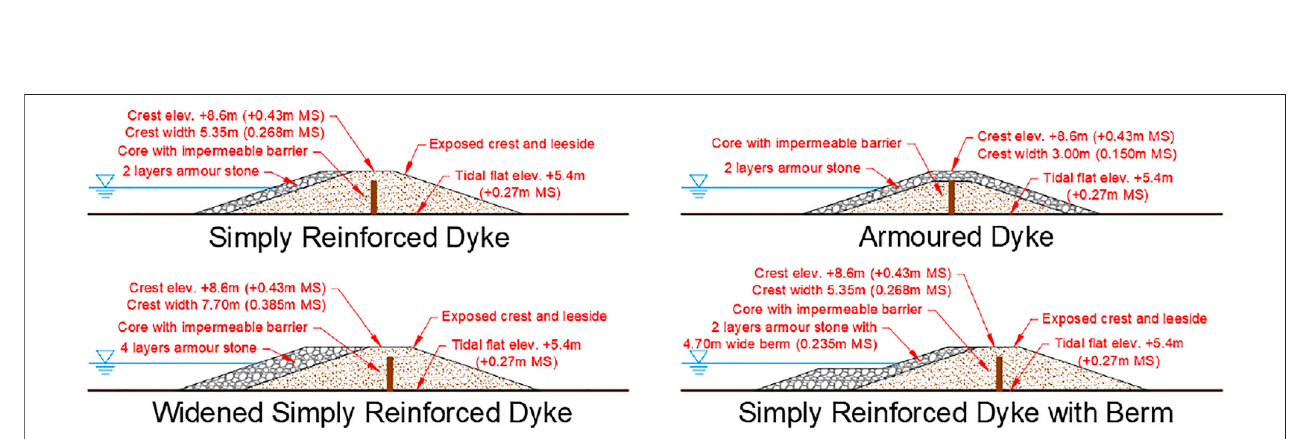
FIGURE 5 | Cross-section drawings for the four dyke structures